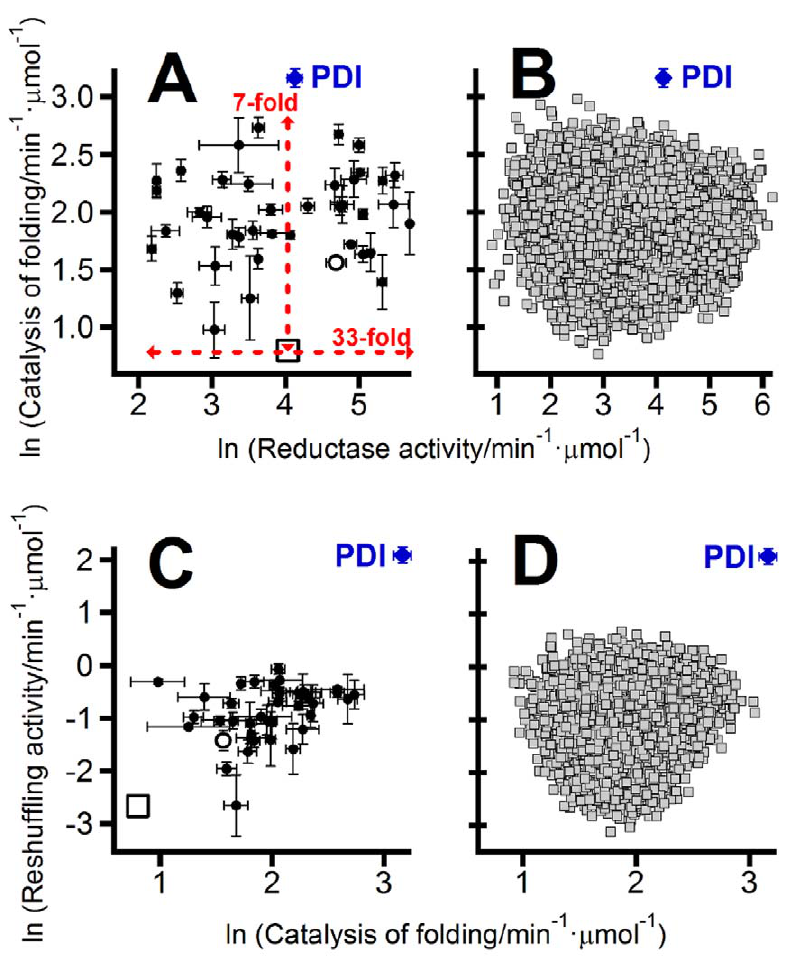
Figure 7. Assessment of the modulation ranges achieved for the primary and promiscuous activities. (A) Experimental reductase and catalysis of oxidative folding data for the expanded 40-variant set, the wild-type thioredoxin from E. coli and the background P34H variant. The meaning of symbols is as in Figure 5A. The approximate modulation ranges achieved are indicated with arrowed red lines. Data of bovine protein disulfide isomerase (blue data point labeled PDI) are also included to provide an evolutionary relevant scale for comparison. Note that specific activity data for PDI are given per molar concentration of active thioredoxin domain. (B) Comparison of the PDI experimental data with the partial least squares reconstruction of the reductase/catalysis-of-oxidative-folding data for the whole combinatorial library. The reconstructed data (grey squares) are actually derived from 20 bootstrapping replicas. (C) Experimental disulfide-reshuffling activity and catalysis of oxidative folding data for the expanded variant set, the wild-type thioredoxin from E. coli and the background P34H variant. Data of bovine PDI are also included to provide an evolutionary relevant scale for comparison. (D) Comparison of the PDI experimental data with the partial least squares reconstruction of the reshuffling/catalysis-of-oxidative-folding data for the whole combinatorial library. The reconstructed data (grey squares) are actually derived from 20 bootstrapping replicas.